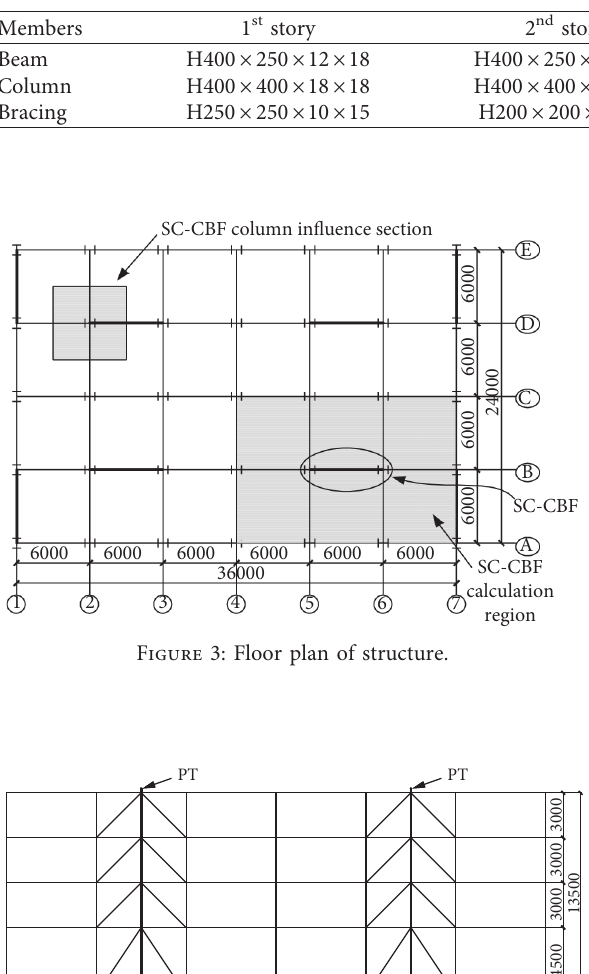
Figure 2: Rocking behavior of the SC-CBF structure. Table 1: Sections of structure members.